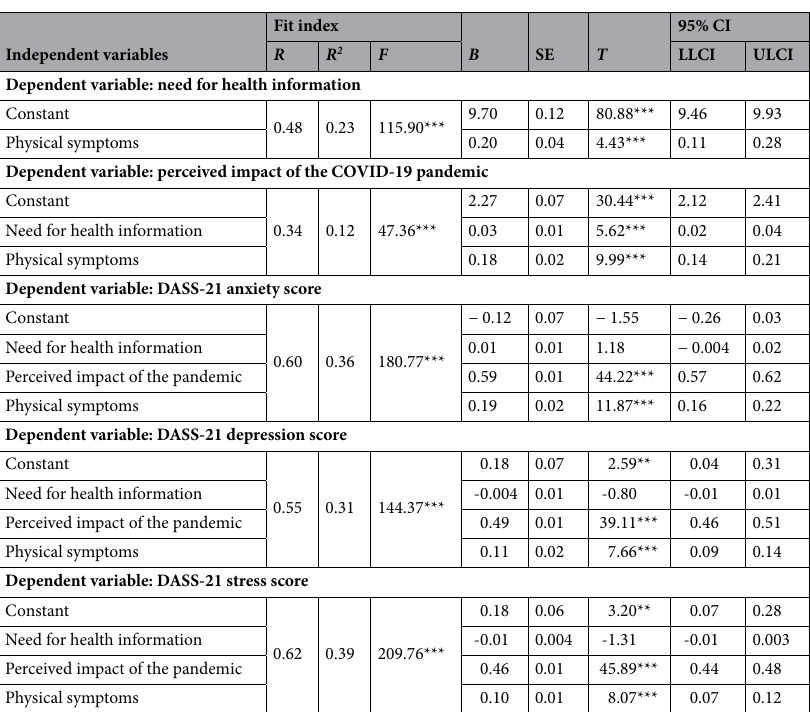
Table 2. Results of mediation analysis. B = unstandardized coefficient. *** Significant at level p <